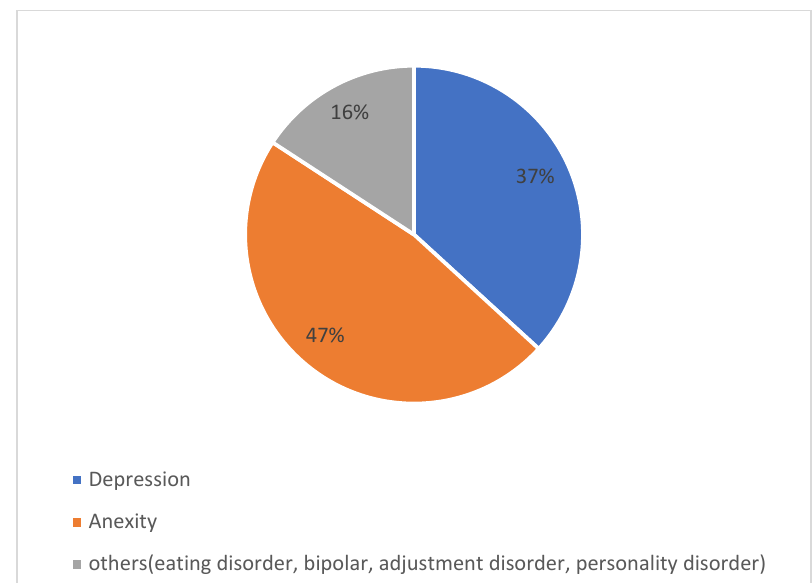
Figure 2. Types of psychological issues reported by the sample students (n = 57).